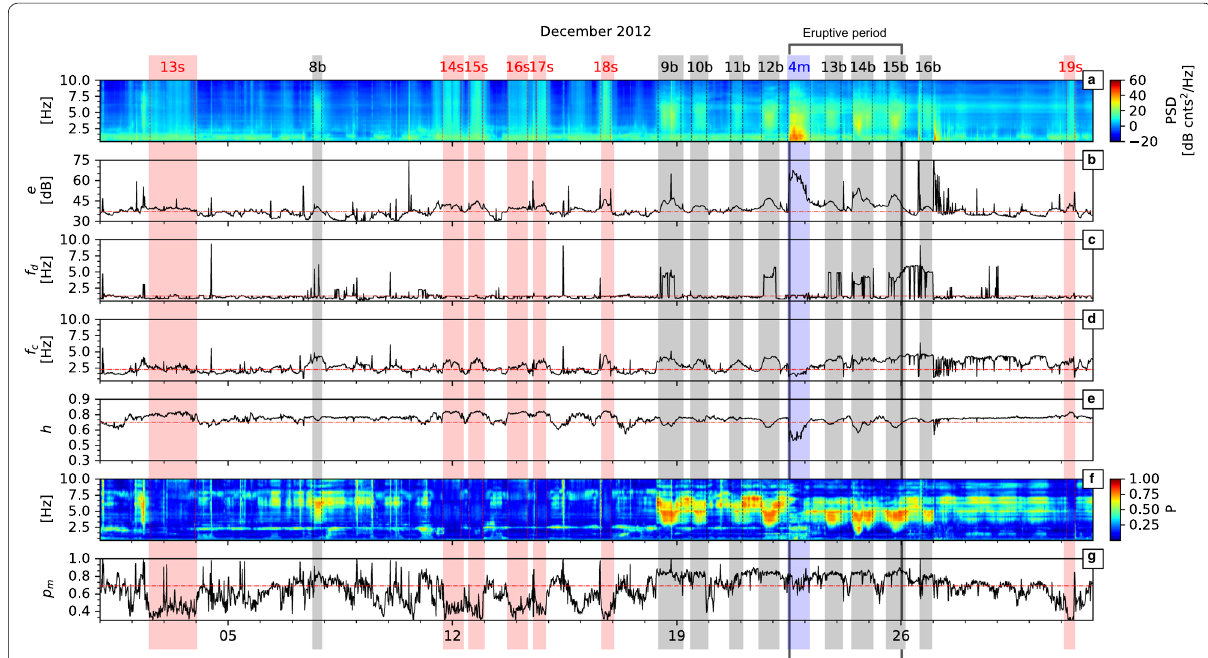
Fig. 2 Time evolution of reduced parameters during December 2012. Time evolution of reduced parameters during December: a spectrogram, b energy, c dominant frequency, d centroid frequency, e permutation entropy, f polarogram, and g dominant polarization degree. The black rectangle centered on December 24 encloses the eruptive stage. The red horizontal dashed lines represent the entire average value of parameters. Different colors are related to different types of events, whereas the codes at the top of shaded bands identify events listed in Additional file